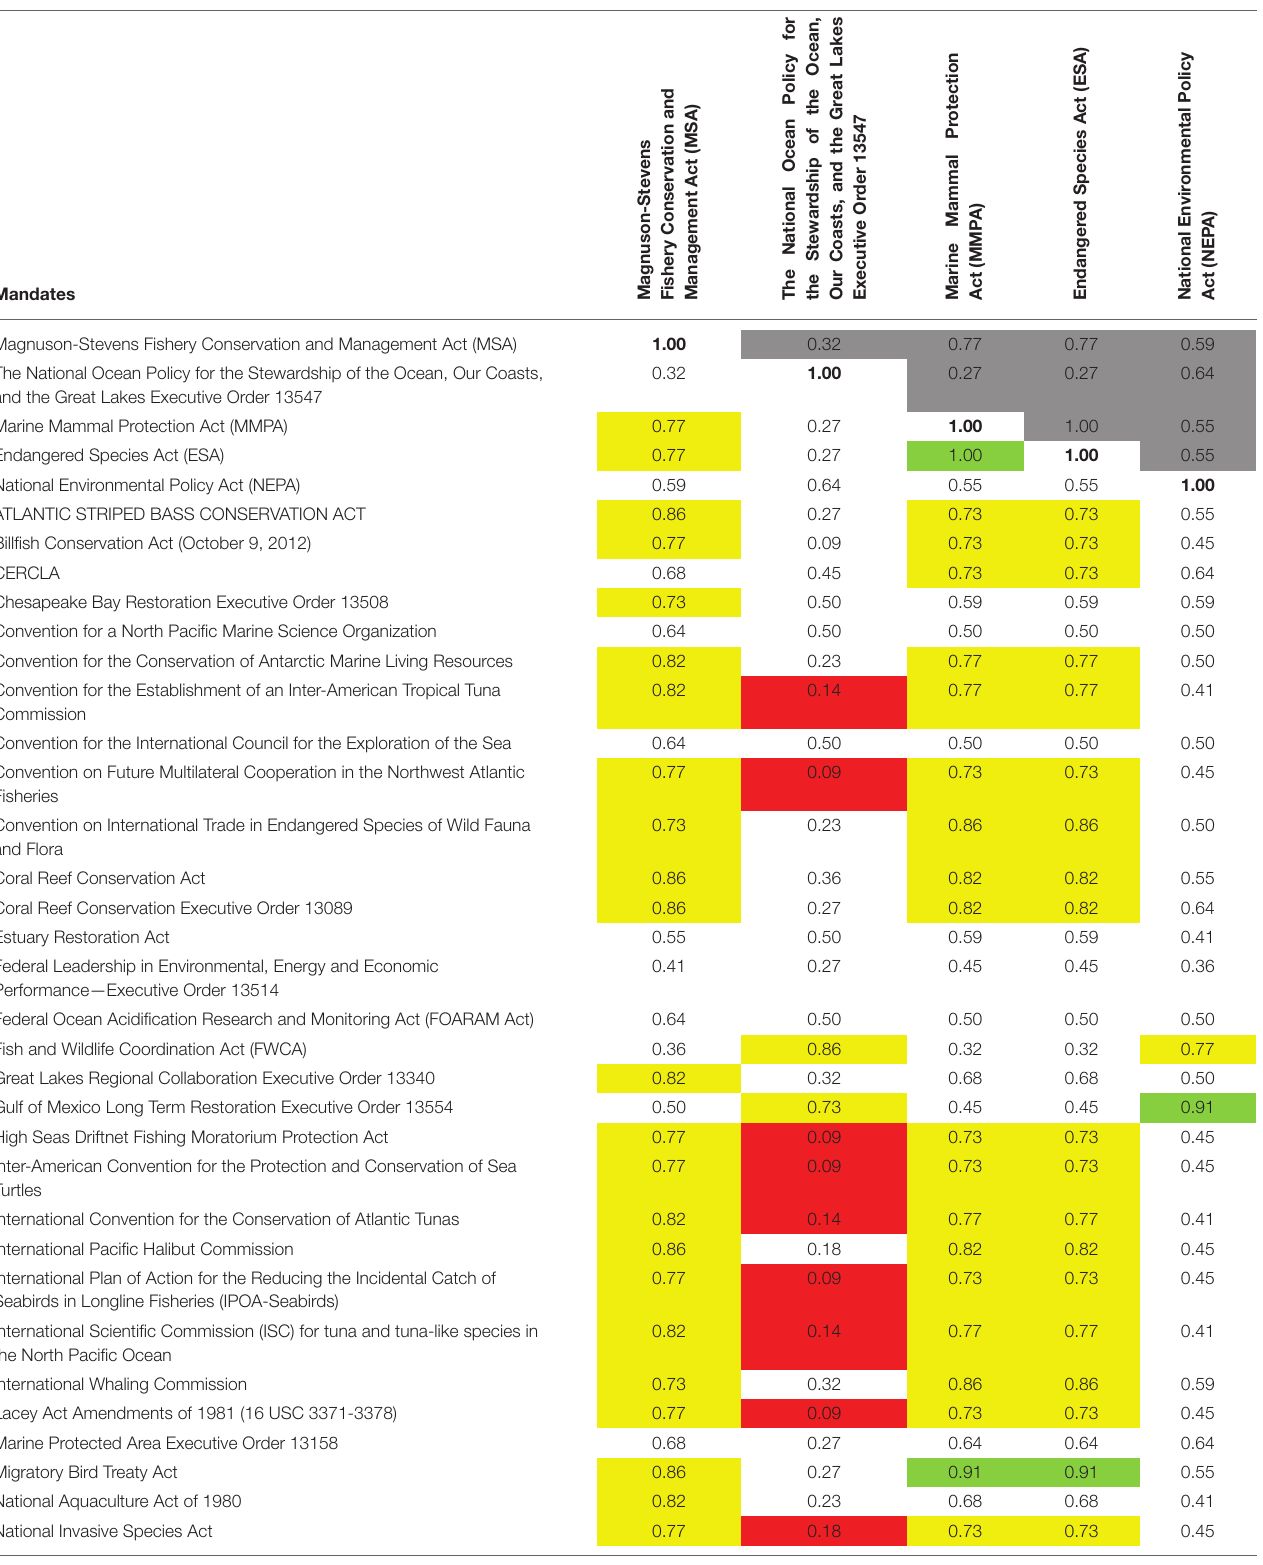
TABLE 4 | A listing of the overlap between the 5 major NOAA-Fisheries mandates and all other